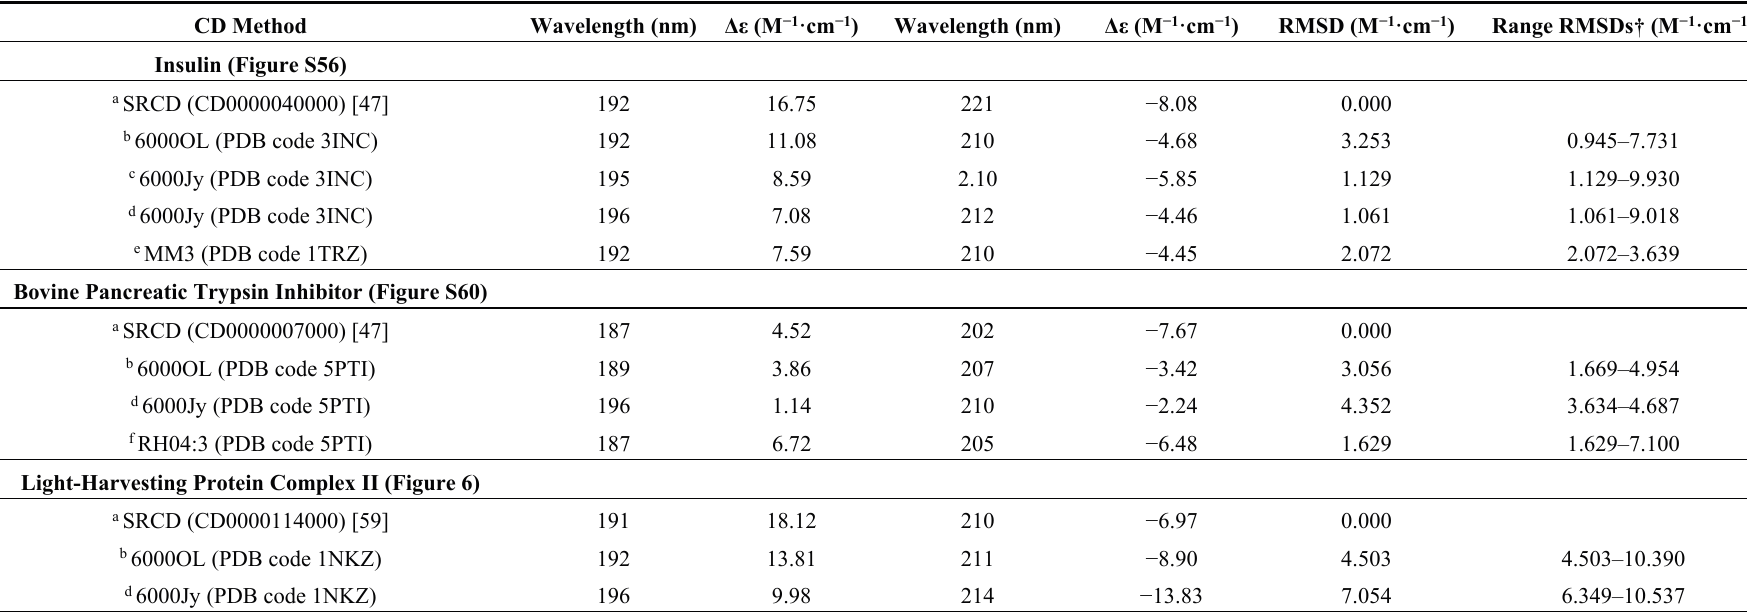
Table 4. CD Analysis of Other Proteins. The DInaMo calculations are for the minimized or rebuilt structure using CDCALC or CAPPS. All RMSDs are calculated between 180 and 210